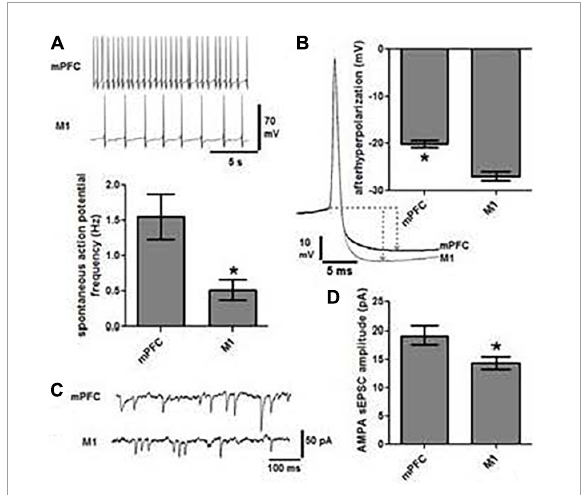
FIGURE7 Locus coeruleus cells projecting to mPFC are physiologically distinct from those projecting to M1. (A) Representative traces of spontaneous action potentials indicate that cells projecting to mPFC ( n = 19) fire three-fold faster than those projecting to M1 ( n = 19, * p < 0.05). (B) The magnitude of afterhyperpolarization (AHP), as determined by the difference in voltage between action potential threshold and the lowest point of the AHP (dashed lines and arrows), was significantly lower in mPFC projection cells than those terminating in M1 (* p < 0.05). (C) Representative traces of AMPA mediated spontaneous excitatory post synaptic current (sEPSC) and the graph in panel (D) indicate that the amplitude of sEPSCs was significantly greater in mPFC vs. M1 projection cells (* p <